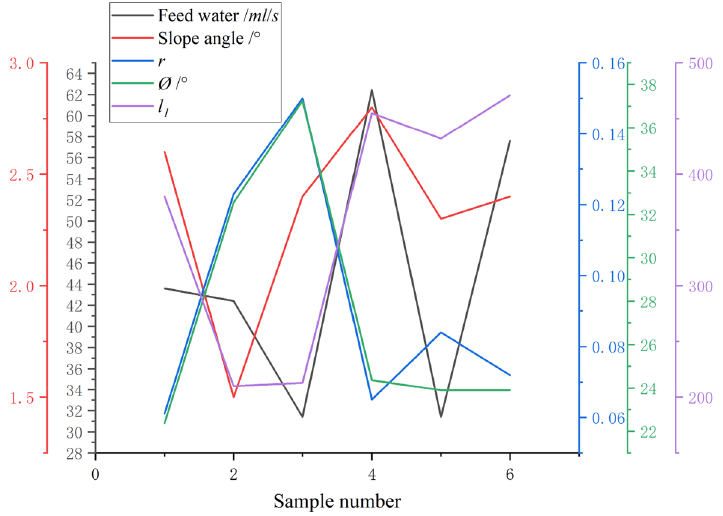
Figure 17. The fluctuation of characteristic parameter value of ore belt of shaking table after one optimization.